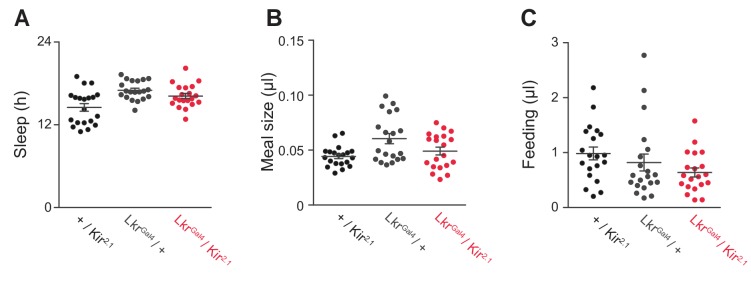
General behavior in Lkr neuronal-silenced animals.(A) Total sleep, (B) meal size, and (C) feeding of LkrGAL4 / Kir2.1 and controls on sucrose + protein diet (Student’s t-test or one-way ANOVA followed by Tukey-Kramer post hoc test for multiple comparisons). Points represent individual animals and lines represent mean ± s.e.m.